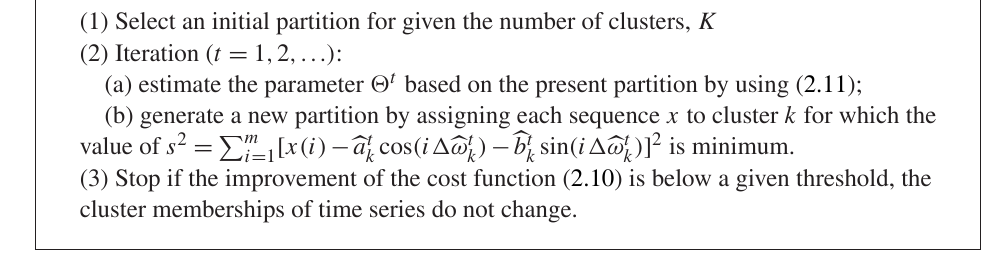
Algorithm 1: Algorithm for nonlinear model-based clustering.